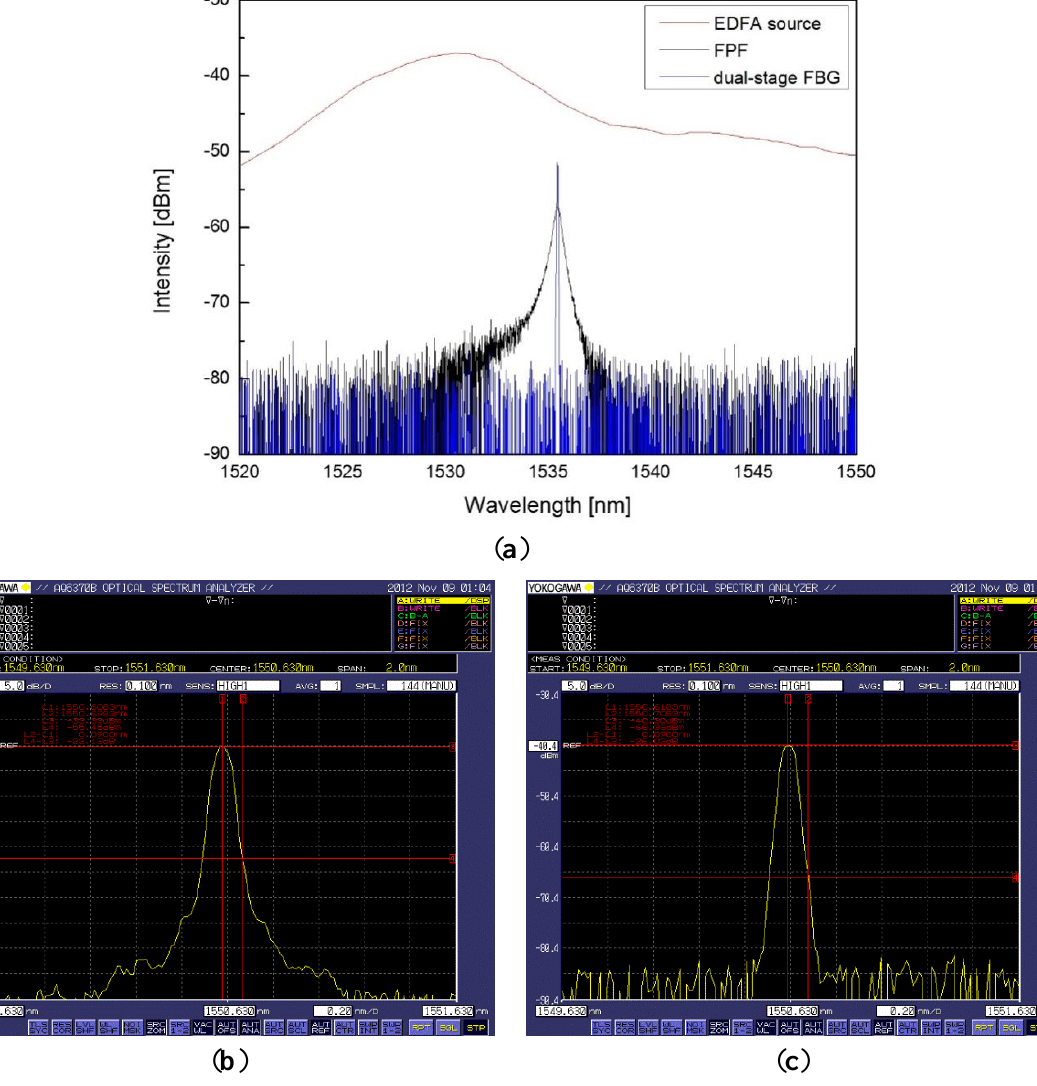
Figure 5. Optical spectrum of ( a ) comparison the dual-stage FBG demultiplexer with